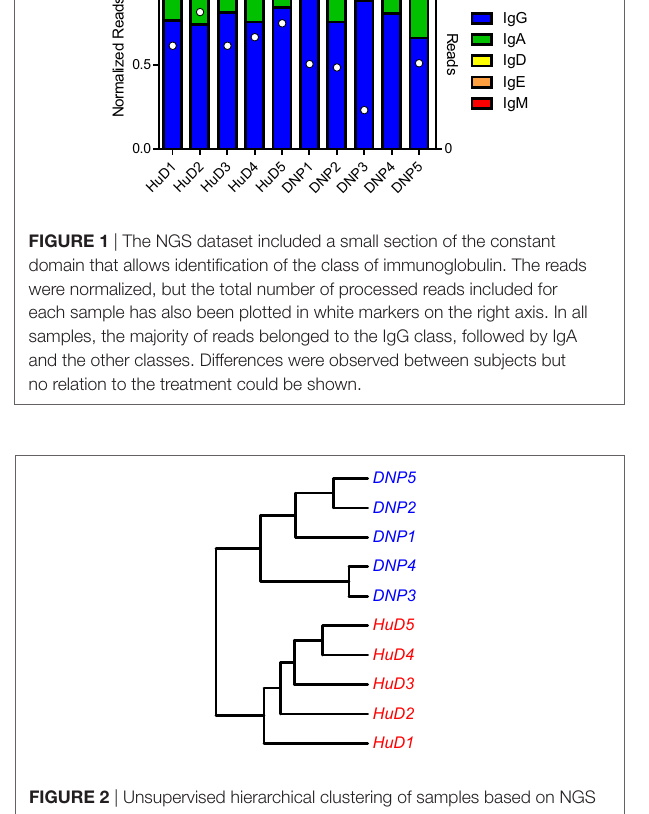
FigUre 2 | Unsupervised hierarchical clustering of samples based on NGS data on the repertoire of unique CDR3 sequences. Cluster analysis based on other regions is provided in the Supplementary